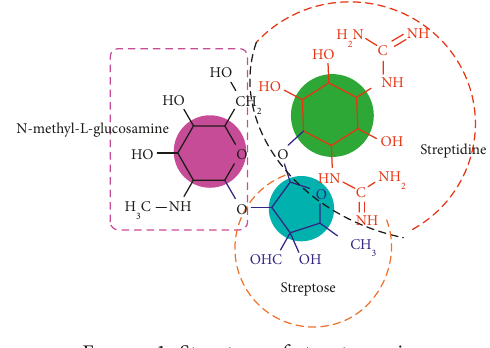
Figure 1: Structure of